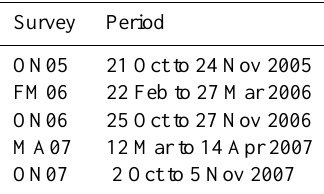
Table 1. ICESat campaigns as used in this